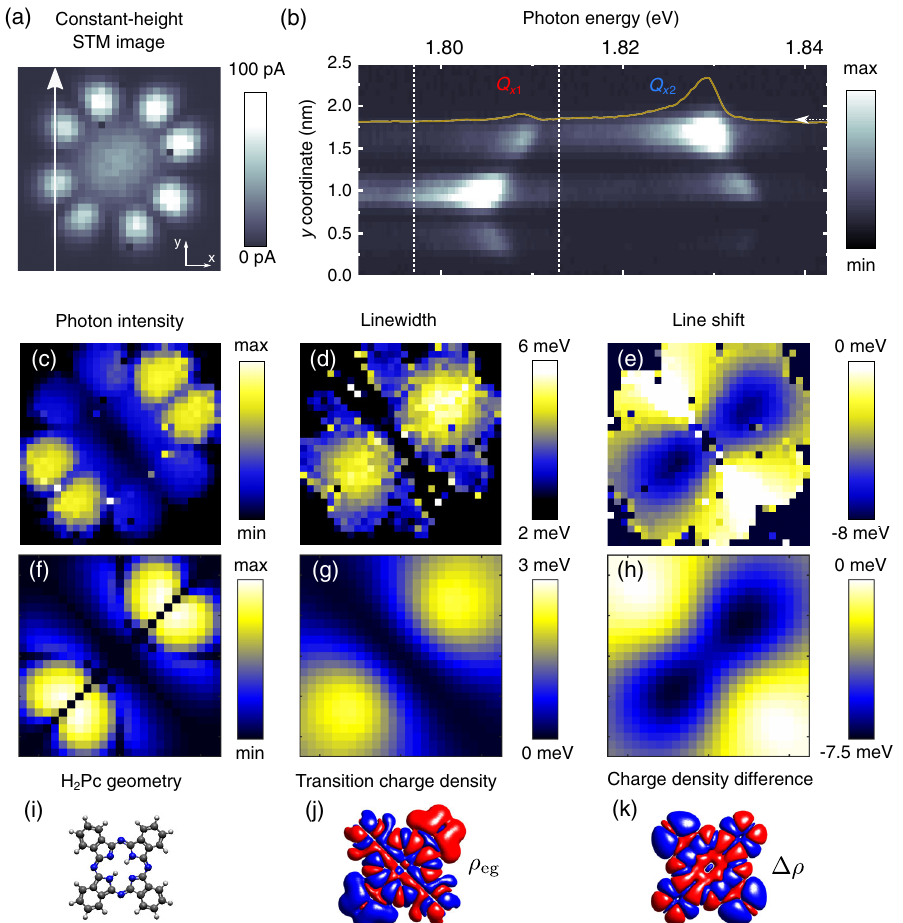
FIG. 3. HRFM mapping of a type-1 H 2 Pc molecule. (a) Constant-height STM current image ( V ¼ − 2 . 5 V, 2 . 5 × 2 . 5 nm 2